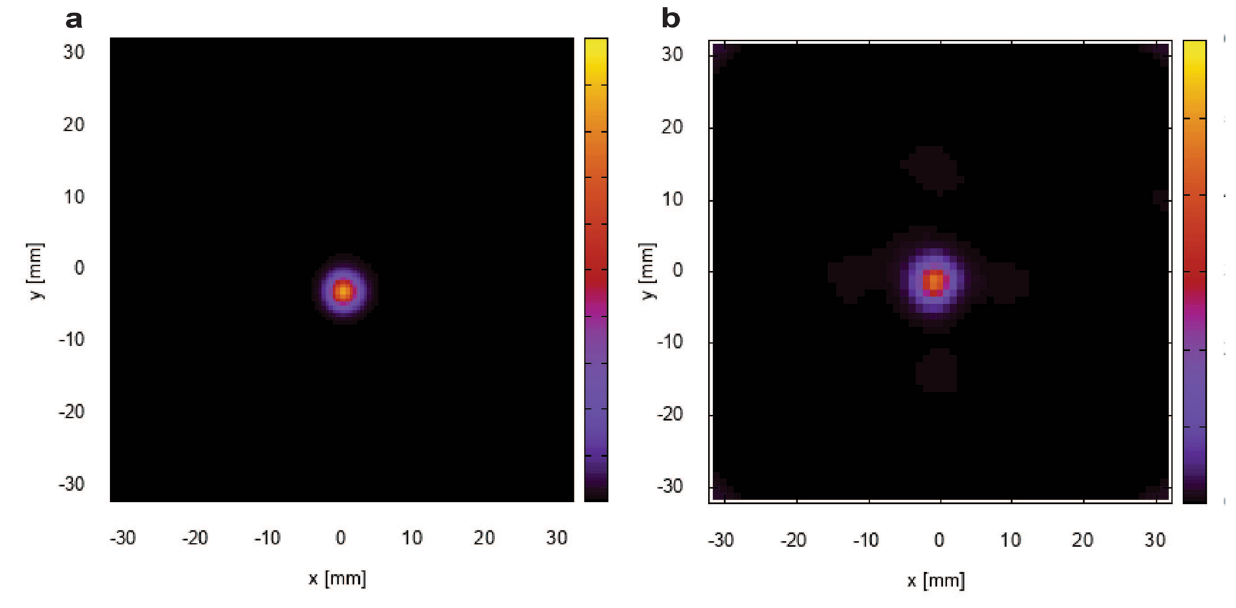
Figure 2. Imaging results for 22 Na and 18 F point sources. (a ) PET image of a 22 Na point source obtained using the BP method. ( b ) Compton image of an 18 F point sources obtained with the MLEM method at a distance of 30